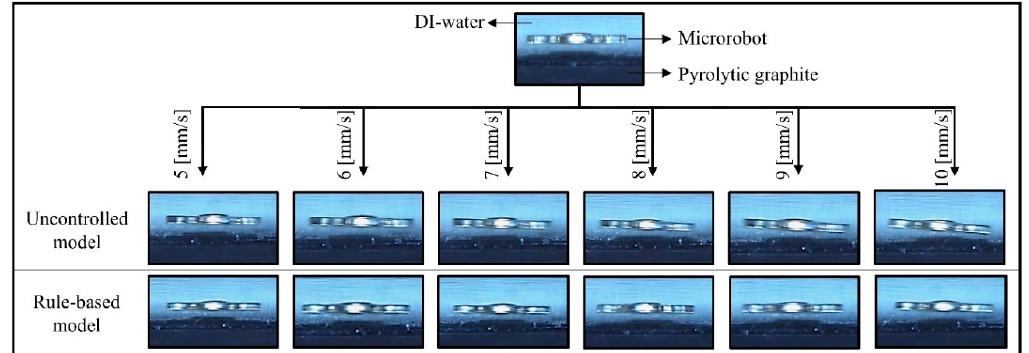
Figure 14. Experimental results to show microrobot head-tilting reaction during implementation of uncontrolled and rule-based models at variable speeds (from 5 mm/s to 10 mm/s). While head-tilting reaction is obvious, in the case of the rule-based model, the microrobot’s lateral motion is slightly developed.